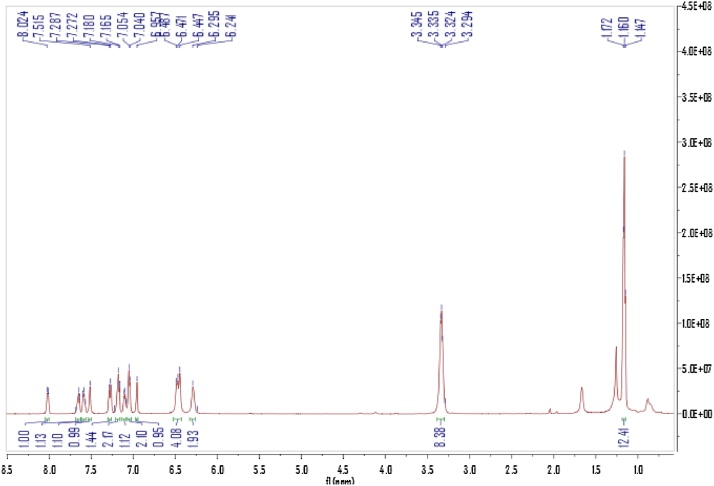
1H NMR of theRS in DCl3.1HNMR(CDCl3, 500 MHz): δ1.160(t, 12H, NCH2CH3), 3.335(m, 8H, NCH2CH3), 6.295(d, 2H, xanthene H), 6.447--6.487(t, 4H, xanthene H), 6.957(S, 1H, NH), 7.047(d, 2H, ArH), 7.097(t, 1H, ArH), 7.172(t, 2H, ArH), 7.279(d, 1H, ArH), 7.515(S, 1H, NH), 7.585(t, 1H, ArH), 7.653(t, 1H, ArH), 8.017(d, 1H, ArH).